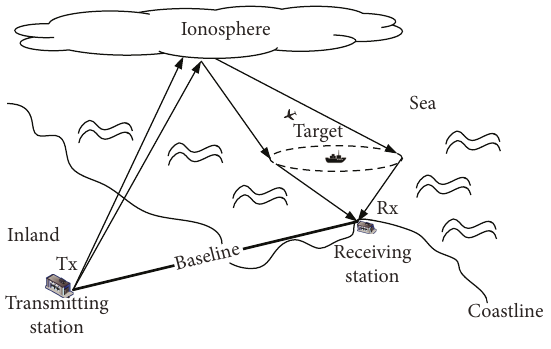
Figure 1: Sketch map of